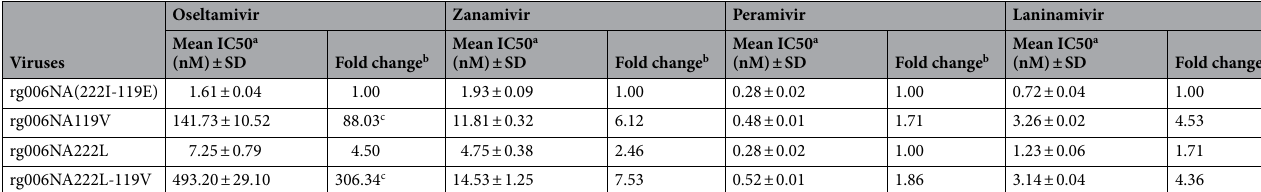
Table 1. Susceptibility of mutant recombinant highly pathogenic H7N9 avian influenza virus to neuraminidase inhibitors. a IC 50 , half-maximal inhibitory concentration. The IC 50 denotes the concentration of a NA inhibitor that reduces the NA activity by 50% relative to NA activity without the inhibitor. b Fold change relative to the mean IC 50 of the wild-type NA protein. Fold-change values of each NA were interpreted using criteria established by the World Health Organization Influenza Antiviral Working Group. c Fold change >10 (including reduced/highly reduced